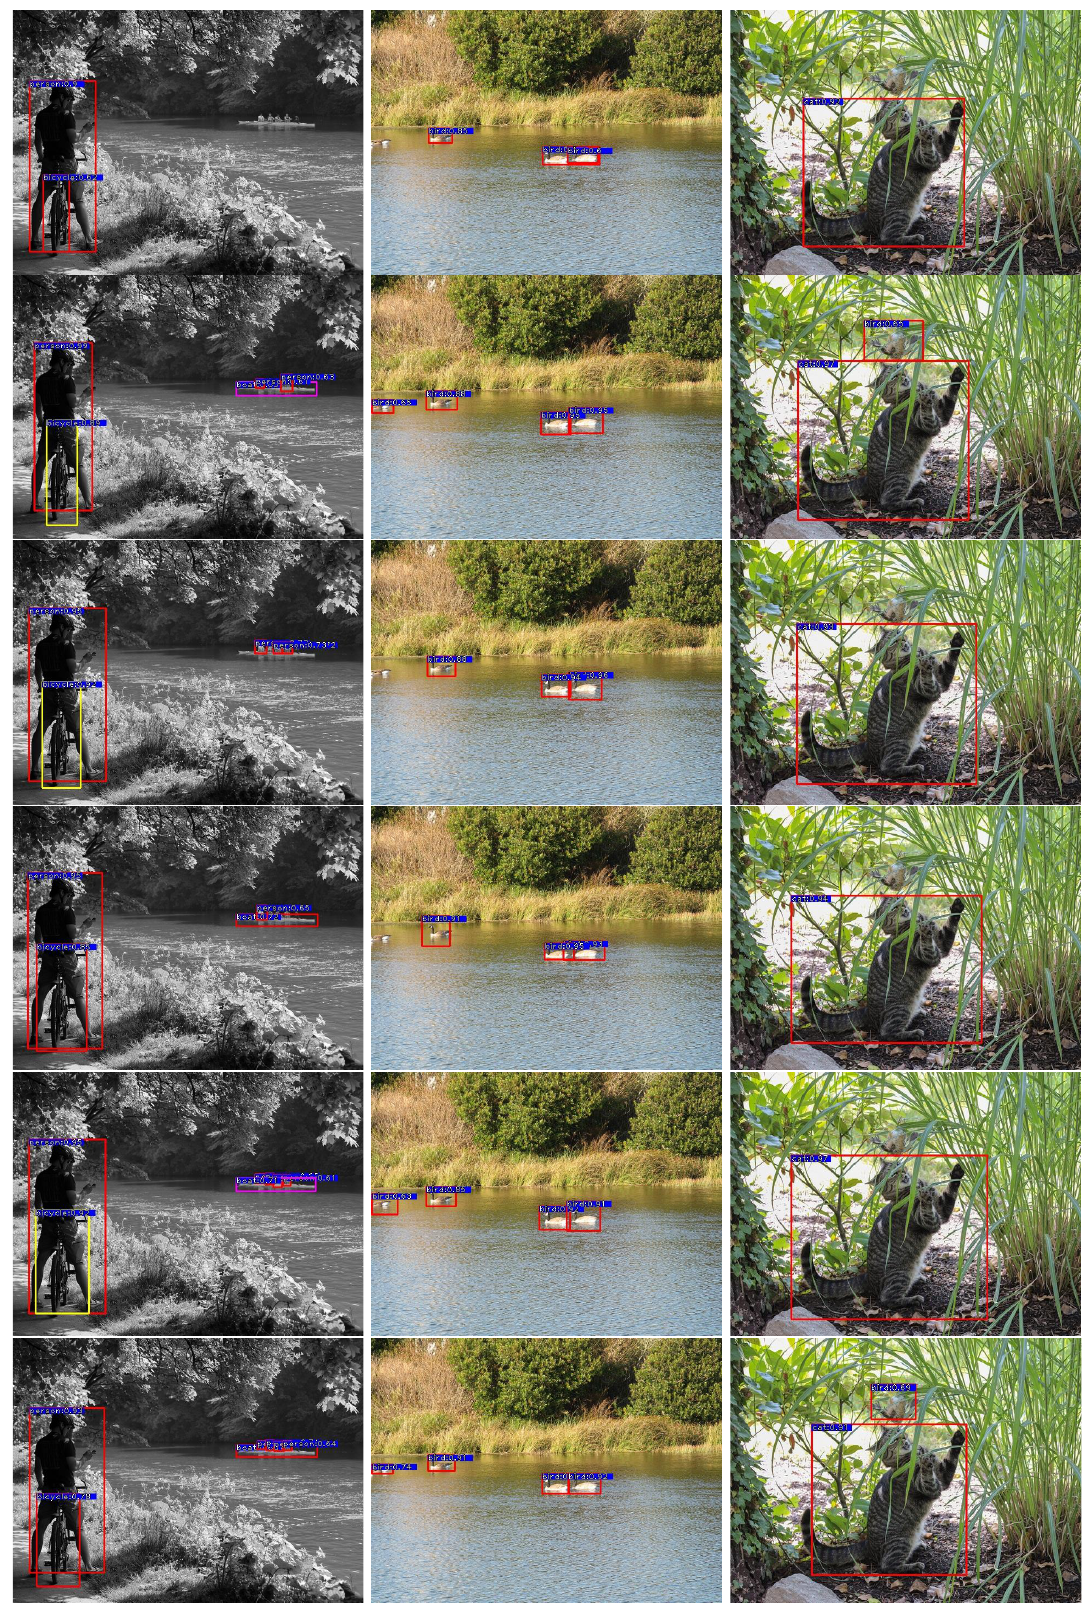
Figure 14. Comparison between our improved detector and recent state-of-the-art detectors. From the first row to the last row, the detection results of YOLOv4, EfficientDet-2, DETR, RDSNet, RetinaNet and ODEM-GAN,